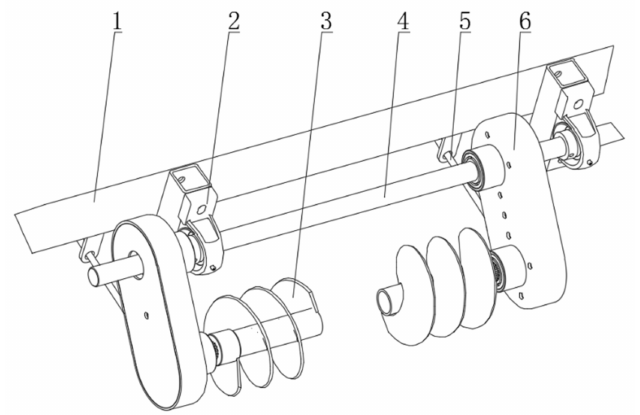
Figure 8. Pad tip cover seedling parts: 1. Support frame; 2. Bearing seat; 3. Screw; 4. Transmission shaft; 5. Screw rod; 6. Chain